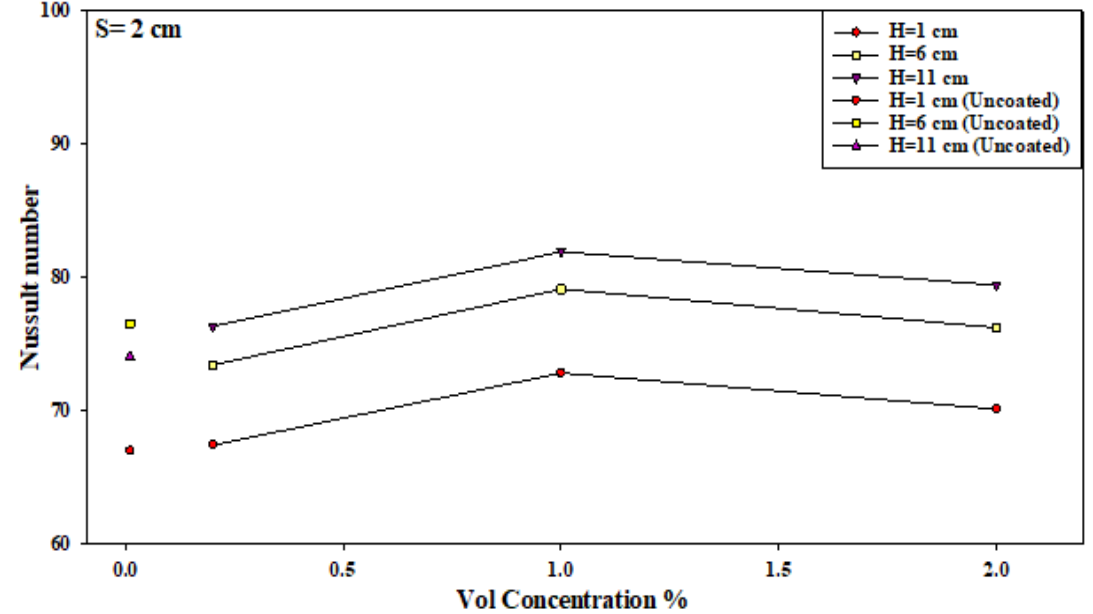
Figure 11. Effect of the nanosolution concentration and nozzle–plate distance when the nozzle–nozzle distance was 2 cm.